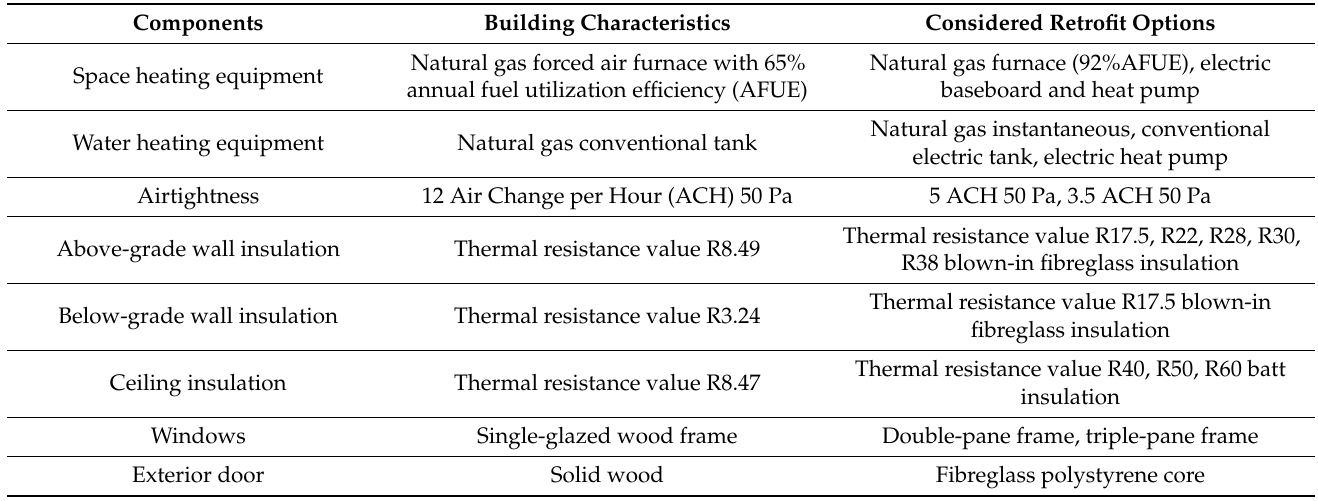
Table 2. Investigated retrofit options for